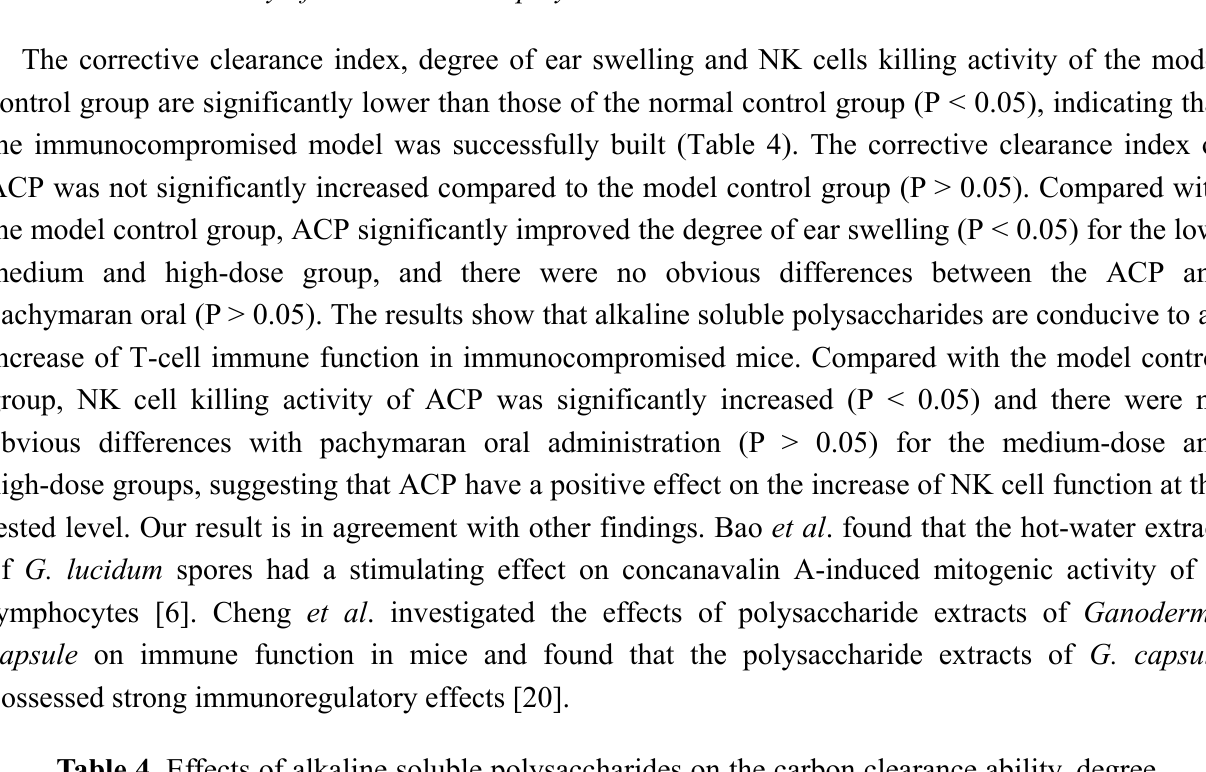
Table 4. Effects of alkaline soluble polysaccharides on the carbon clearance ability, degree of ear swelling and NK cell killing activity of mice ( ±